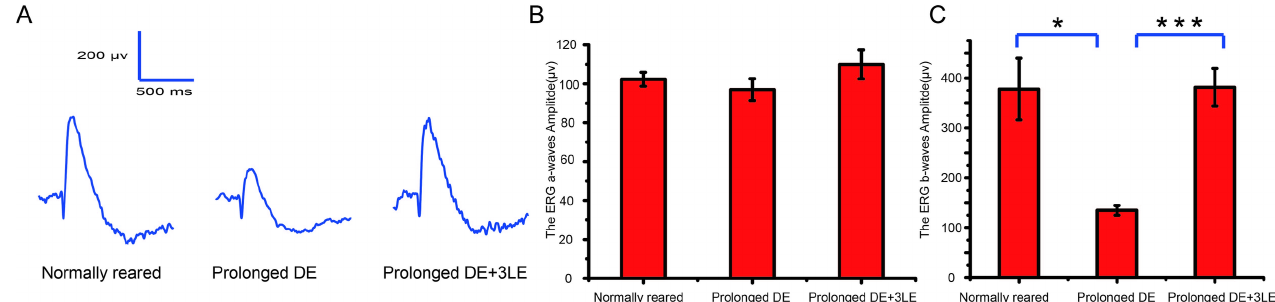
Fig 7. The ERG a-wave and b-wave after prolonged dark exposure in rats. (A)Typical cases of ERG waves to the 0.82 log cd * s/m 2 light stimulus in three groups of rats (Left to right: normally reared group, prolonged dark exposed group, recovery group which was the prolonged dark exposed group followed by 3 repetitive, brief (10 minutes) light exposure). (B) The statistics of the a-wave amplitudes in three groups (n = 4). (c) The statistics of the b-wave amplitudes in three groups (n = 4). ( * p < 0.05, t test, error bars ±